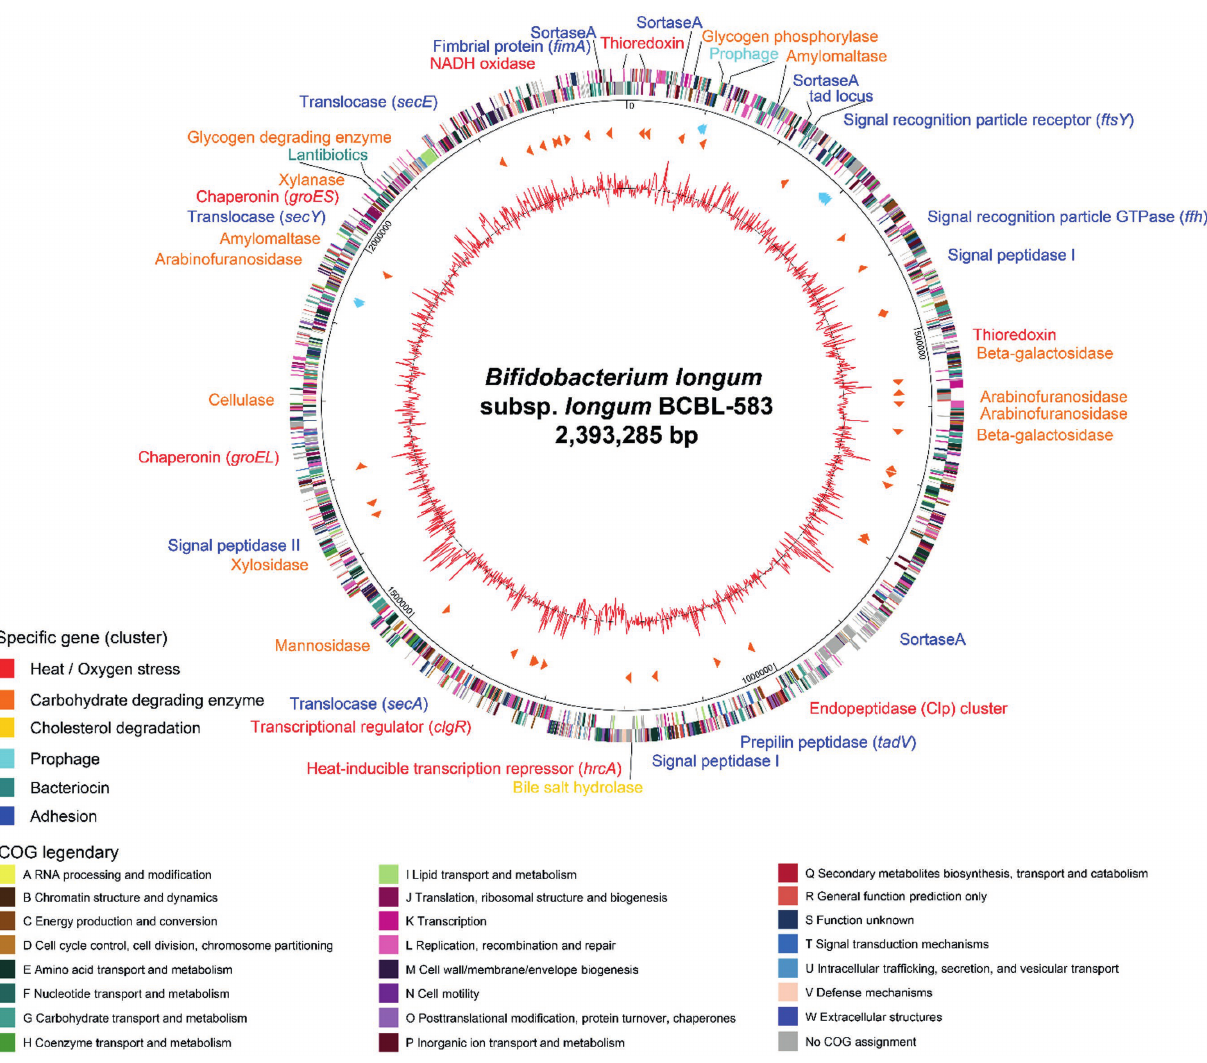
FIGURE 2 | Circular genome map of Bifidobacterium longum BCBL-583. The outer circle indicates the location of all annotated open reading frames (ORFs) in double strands colored by clusters of orthologous groups (COG), and the inner circle with red peaks indicates GC content. Between these circles, sky blue arrows indicate the rRNA operons, and orange arrows indicate the tRNAs. Specific genes or gene clusters were colored according to their functions in upper legend. The colors of COG categories were indicated in lower